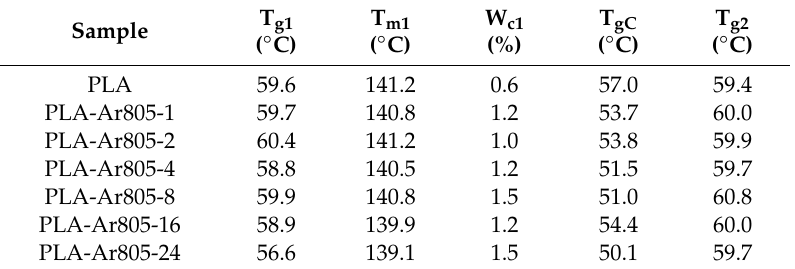
T g1 = glass transition temperature (first heating stage). T m1 = melting temperature (first heating stage). W c1 = crystallinity degree (first heating stage). T gC = glass transition temperature (cooling stage). T g2 = glass transition temperature (second heating stage).